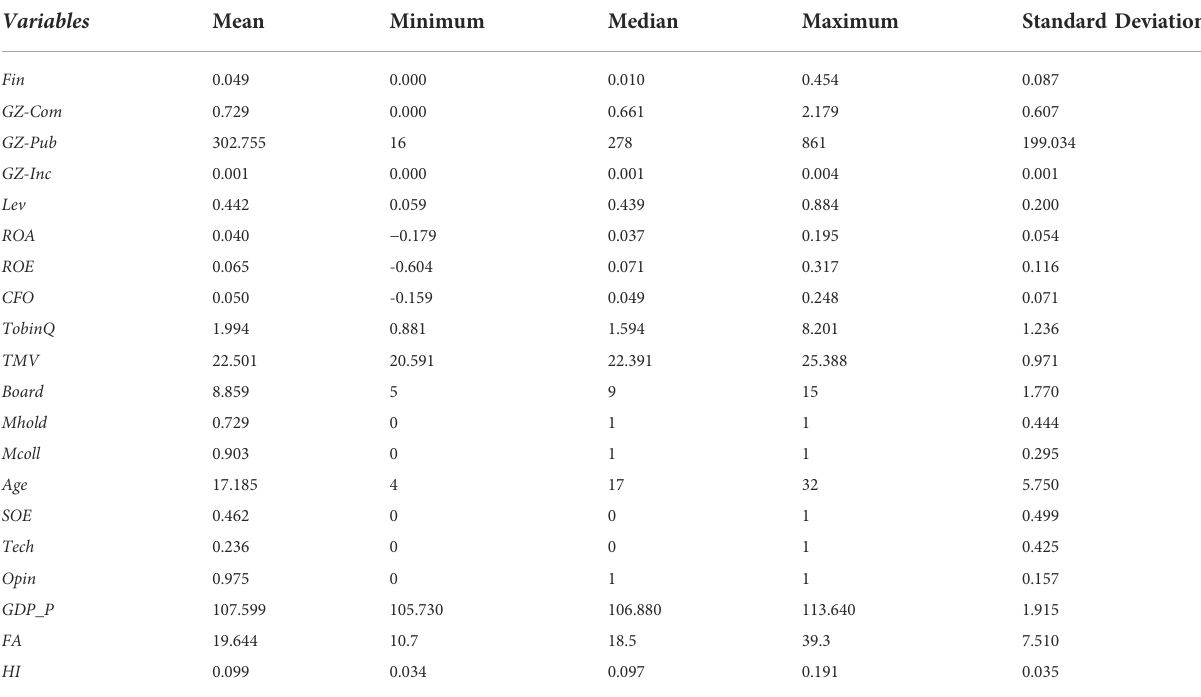
TABLE 2 Descriptive statistics for the main